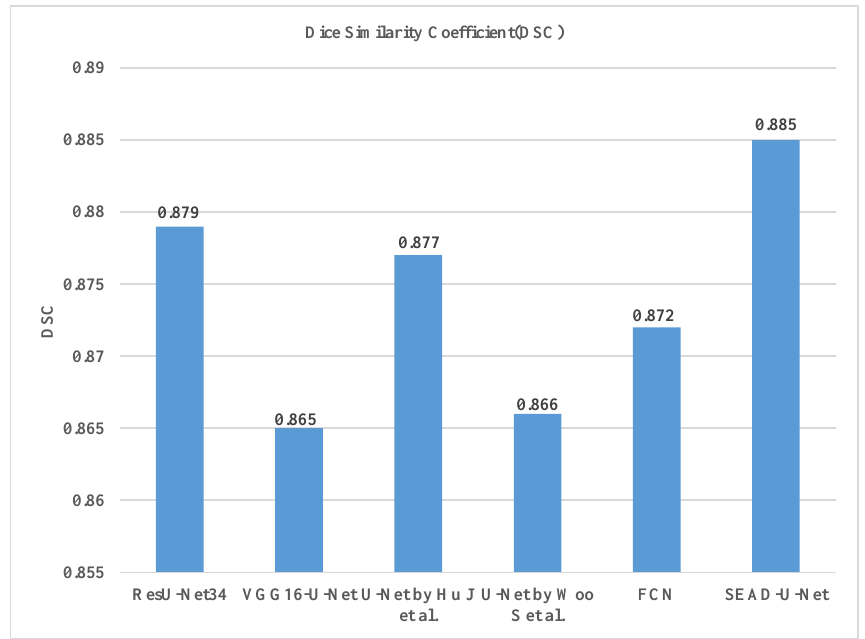
Figure 7. The DSC comparison of the different